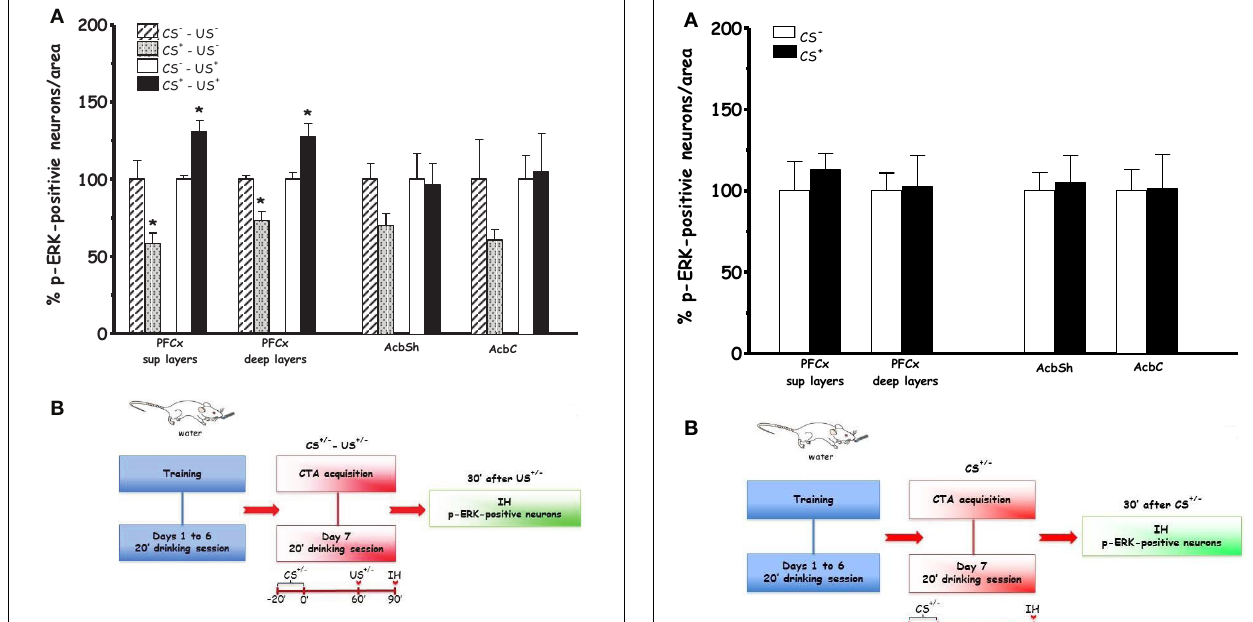
0.9%) and administered intraperitoneally (i.p.) at the doses, respectively, of 125 mg/kg/2 ml and 450 mg/kg/5 ml. D-Sucrose (Sigma Aldrich, Italy) solutions (15% w/v), made in tap water, were freshly prepared on the day of